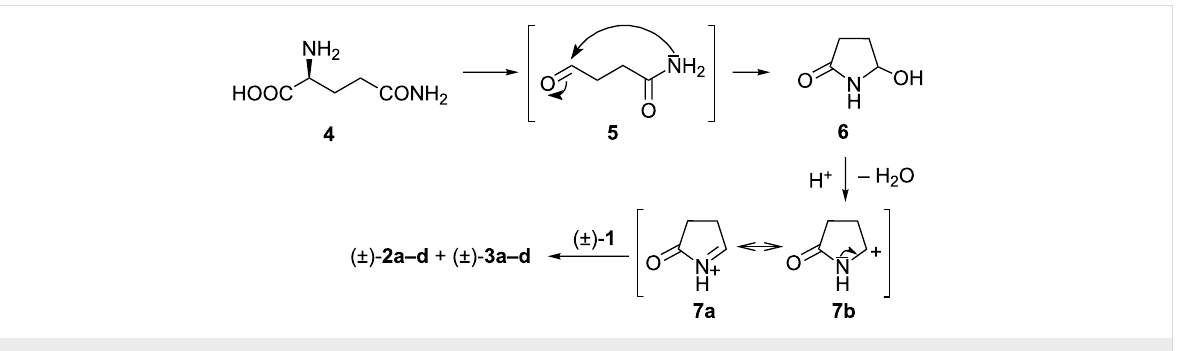
Scheme 1: Proposed biosynthetic route to dracocephins A and